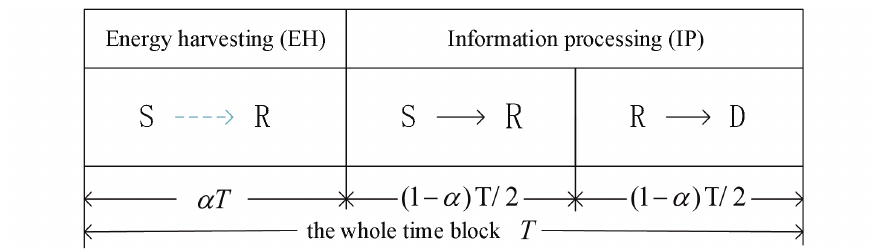
Figure 2. Transmission time-block structure for the TS